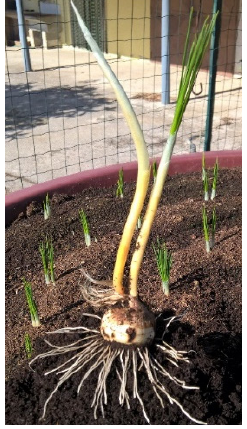
Figure 4. Infected corm lifted from sector 3 of the pot.